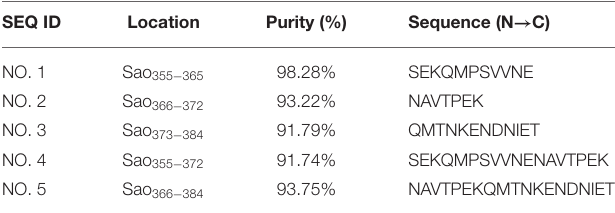
TABLE 3 | Amino acid sequence of five candidate B-cell epitopes of Sao-M